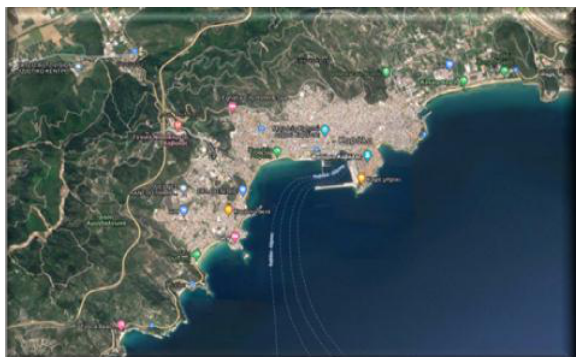
Figure 3 . Photography of Behind -